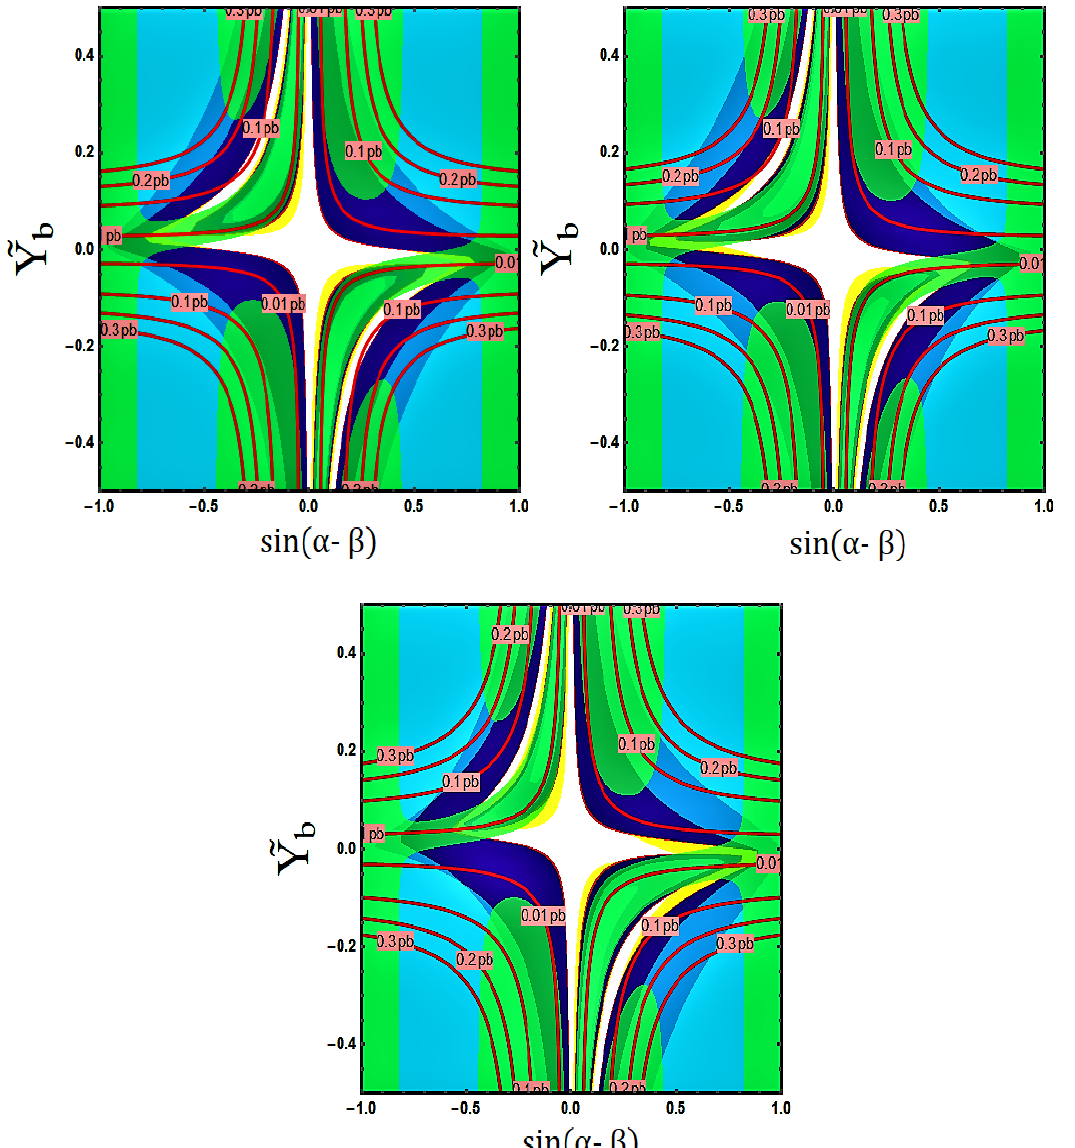
Figure 14 . Cross-section in bottom Yukawa coupling ~ Y b and mixing angle sin( (cid:11) (cid:0) (cid:12) ) plane for pseudoscalar A production in association with b quarks and subsequent decay to Zh . The colored region is excluded from SM Higgs properties. We set top Yukawa ~ Y t = 0 (top left), (cid:0) 0 : 3 (top right) and 0 : 5 (bottom).